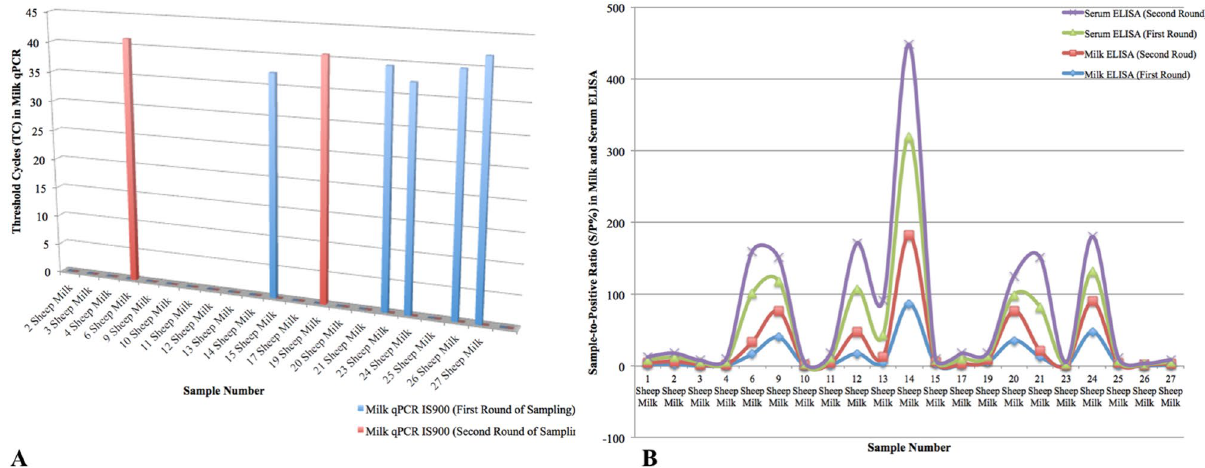
Figure 5. Comparison among the results of three diagnostic assays of milk qPCR, milk ELISA, serum ELISA at the first and second rounds of sampling. This comparison is based on threshold cycles (TC) and sample-to- positive ratio (S/P%) generated in qPCR IS 900 ( A ) and milk/serum ELISA ( B )